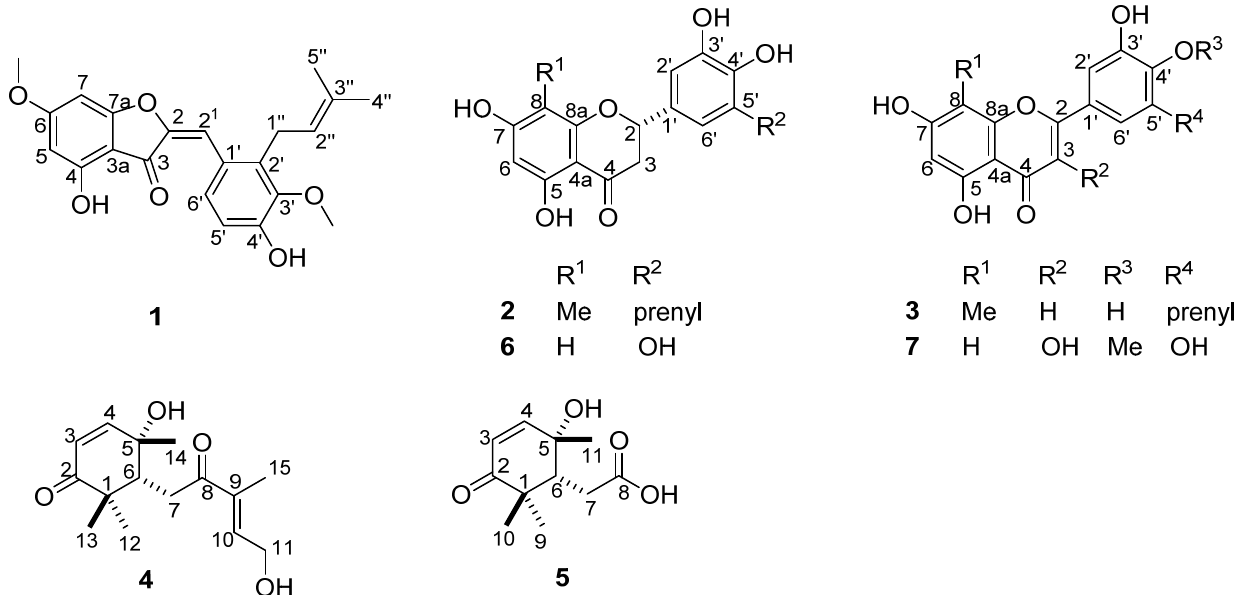
Figure 1. Chemical structures of isolated compounds ( 1 – 7 ) from I. cylindrica. Compound 1 was isolated as an orange powder and its molecular formula C 22 H 22 O 6 was deduced from HRESI-MS, which showed the pseudomolecular ion [M + Na] + at m / z 405.1300 (calcd. m / z 405.1308 for C 22 H 22 O 6 Na + ). The IR spectrum showed absorption bands at 3306 (O–H), 2923 (C–H), 1709 (C=O), 1610 (C=C), and 1069 (C–O) cm − 1 . The NMR spectra (Table 1) of 1 exhibited two meta-coupled aromatic resonances at δ H / δ C 6.38 (1H, d, J = 2.1 Hz, H-7)/90.2 (C-7) and 6.13 (1H, d, J = 2.1 Hz, H-5)/97.7 (C-5); a one-proton singlet at δ H 6.90 (1H, s, H-2 1 ) attributable to aurone-type flavonoids [29,30]; and aromatic AB-type resonances at δ H / δ C 7.93 (1H, d, J = 8.2 Hz, H-6 (cid:48) )/129.5 (C-6 (cid:48) ) and 6.83 (1H, d, J = 8.2 Hz, H-5 (cid:48) )/115.5 (C-5 (cid:48)